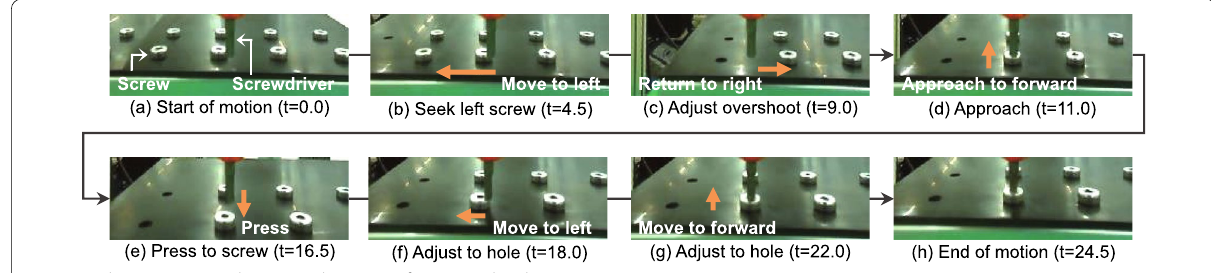
Fig. 9 Task execution result: approaching top of screw and picking it up